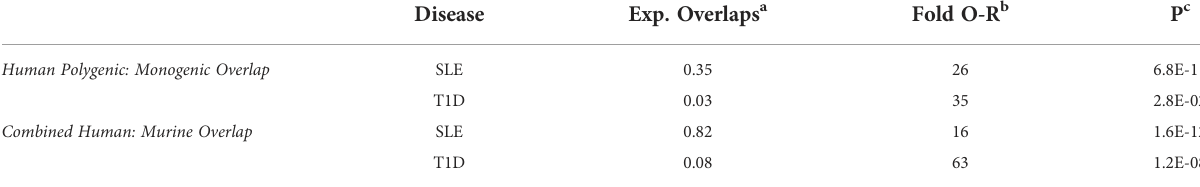
TABLE 2 Disease Network